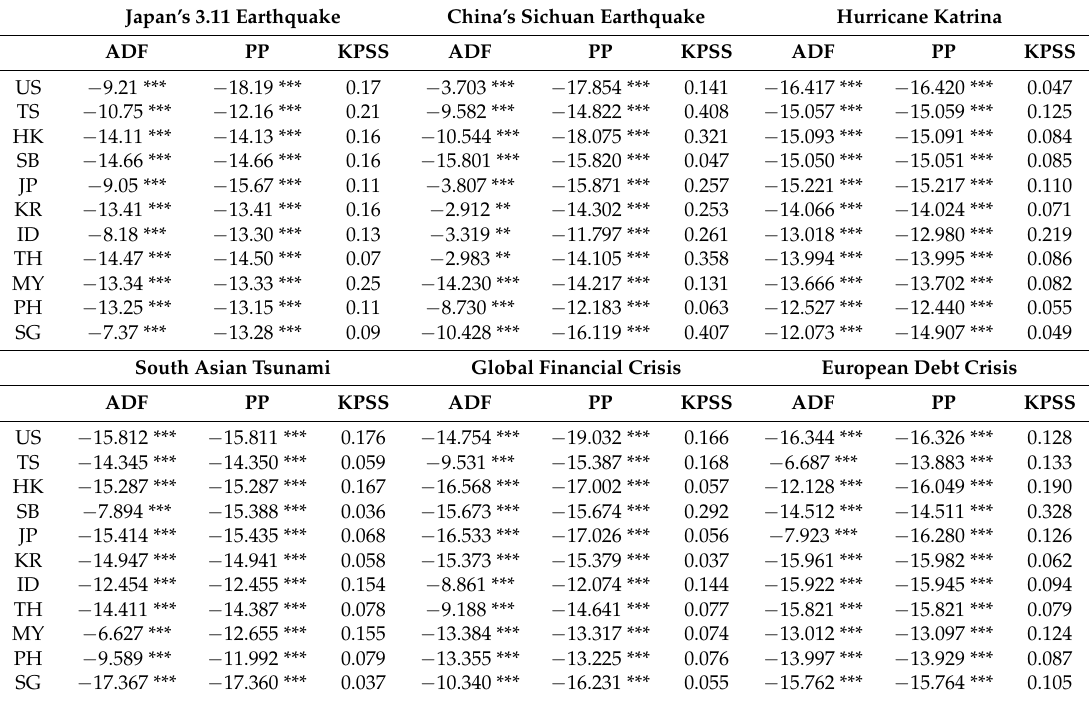
Table 11. Unit root test